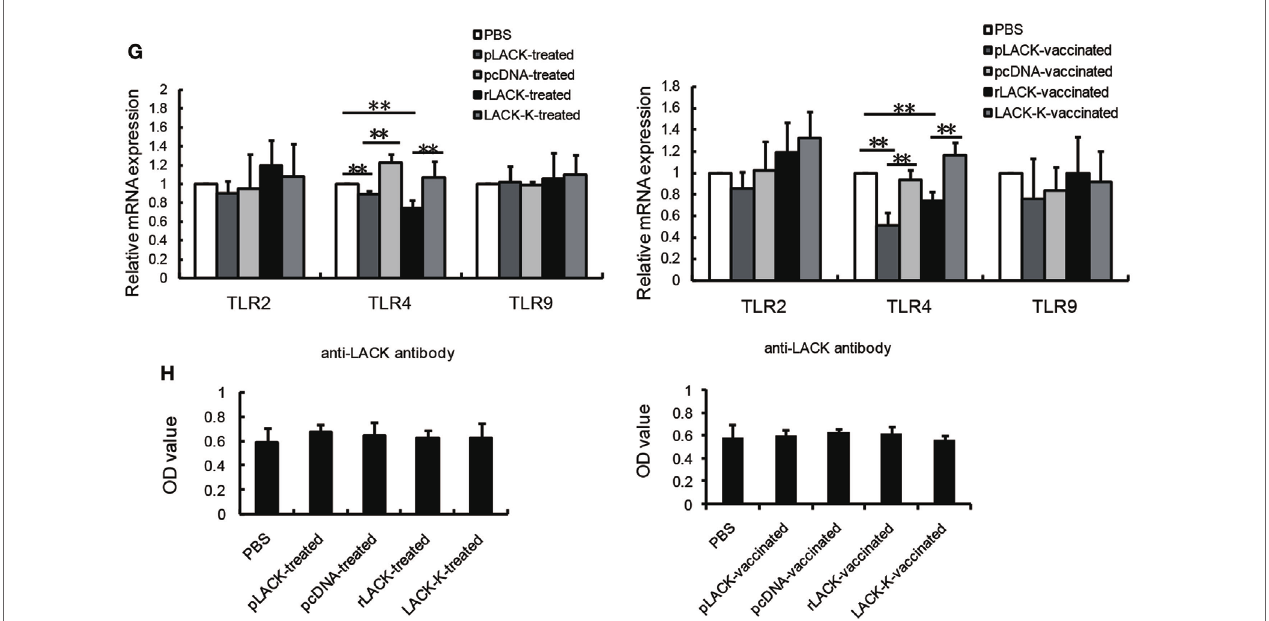
FigUre 1 | The effect of the LACK 156–173 epitope in mice with collagen antibody-induced arthritis (CAIA). CAIA mice in the treatment groups were injected with PBS/ pLACK/pcDNA (100 µg) or PBS/rLACK/LACK-K (50 µg) on day 4. CAIA mice were vaccinated 7 days before monoclonal antibody (mAb) injection. (a–D) The effects of Plack/rLACK treatment (a,B) and vaccination (c,D) on the arthritis scores and histopathology of CAIA mice. Original magnification, 100 × . Eight animals in each group. (e) T cell transcription factor and cytokine gene expression in the knee synovium of CAIA mice at day 14. (F) The gene expression levels in normal mice injected with the LACK 156–173 epitope. Normal mice were injected with PBS/pLACK/pcDNA (100 µg) or PBS/rLACK/LACK-K (50 µg). 7 days later, T cell transcription factor and cytokine gene expression in the knee joints of mice were determined by quantitative real-time polymerase chain reaction. (g) Toll-like receptors (TLRs) gene expression in the knee synovium of CAIA mice at day 14. (h) Anti-LACK 156–173 epitope antibodies in the sera of CAIA mice were determined by enzyme-linked immunosorbent assay at day 14. The data are expressed as the mean ± SEM for five animals in each group, combined from at least three independent experiments. * p < 0.05, ** p <